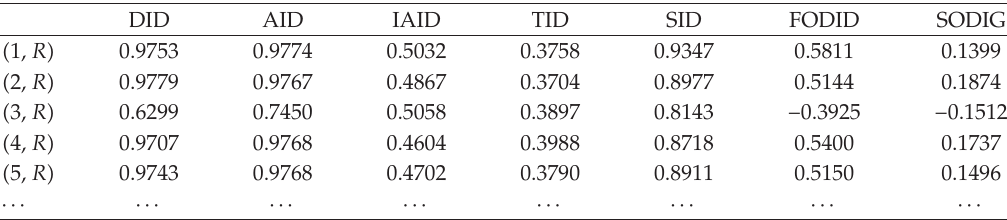
Table 1: Seven incidence degrees between cross level time series and reference cross level time series. DID AID IAID TID SID FODID